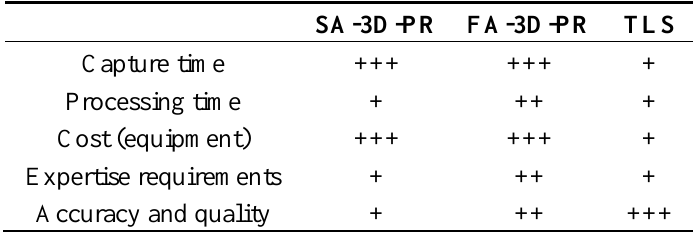
Table 6. Qualitative comparison of the three methods used here (Semi-Automatic 3D Photo-Reconstruction: SA-3D-PR, Fully Automatic 3D Photo-Reconstruction: FA-3D-PR, and Terrestrial Laser Scanner: TLS), from excellent (+++) to good (++) and moderate